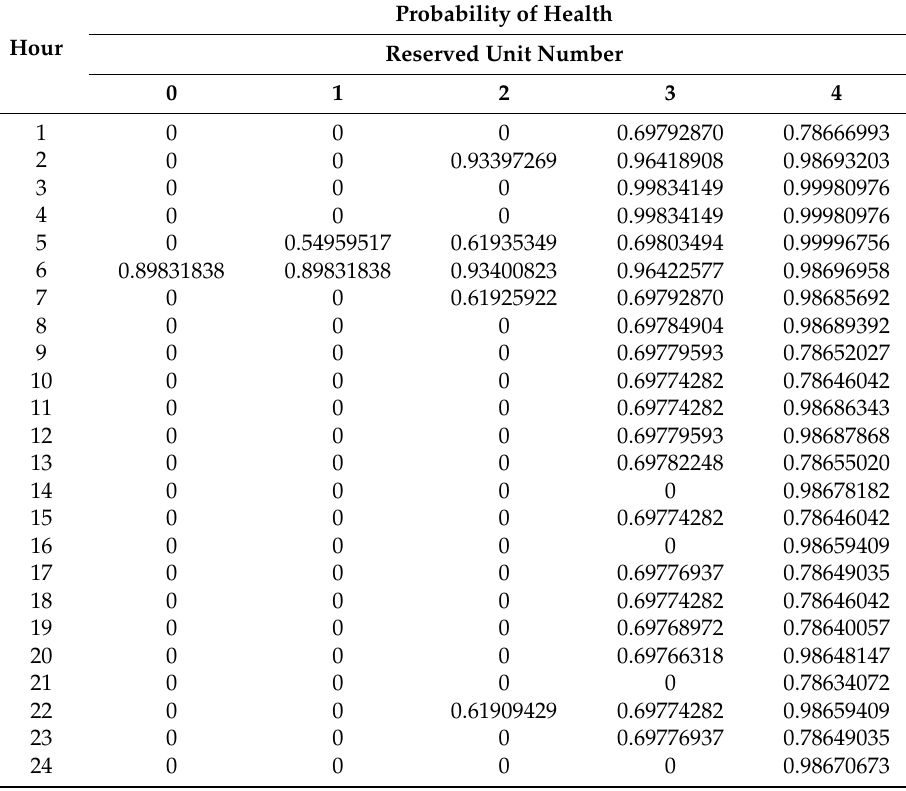
Table 4. Probabilities of health under scenario (1) with a certain number of GT units set aside as reserves.